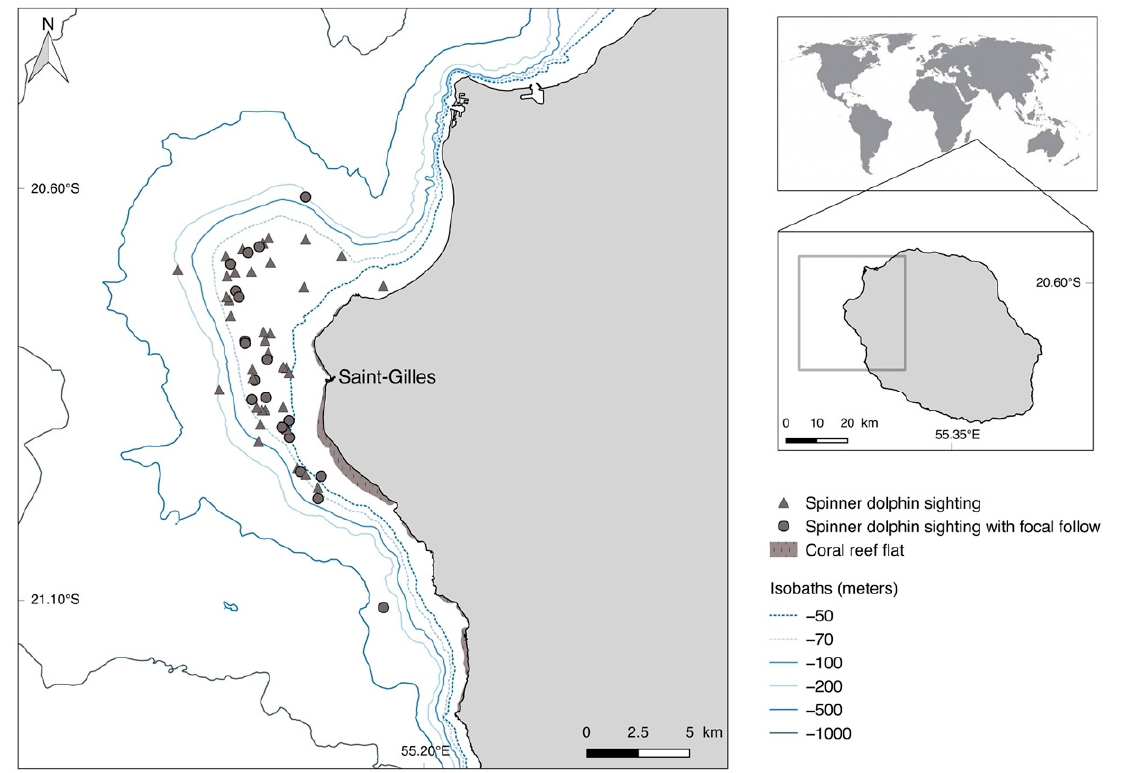
Figure 1. Study area and spinner dolphin sightings between February 2018 and June 2020 along the western coast of Reunion Island in the south-western Indian Ocean.